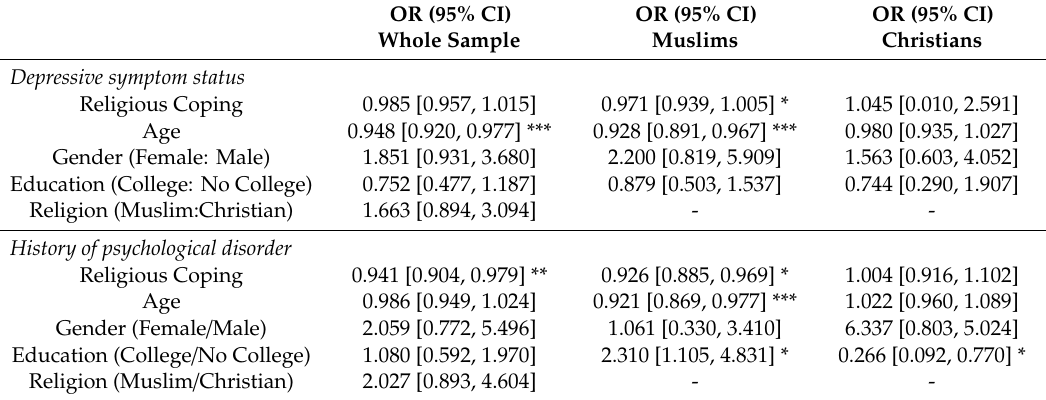
Table 4. Multivariate logistic regression predicting depressive symptom status and history of psychological disorder among Christians and